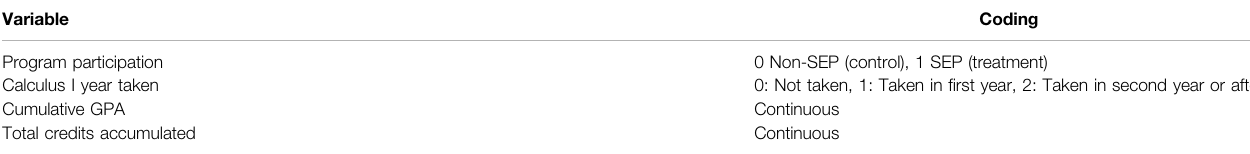
TABLE 3 | Coding for Independent Variables. By Dina Ghazzawi, Donna Pattison, and Catherine Horn. Variable Program